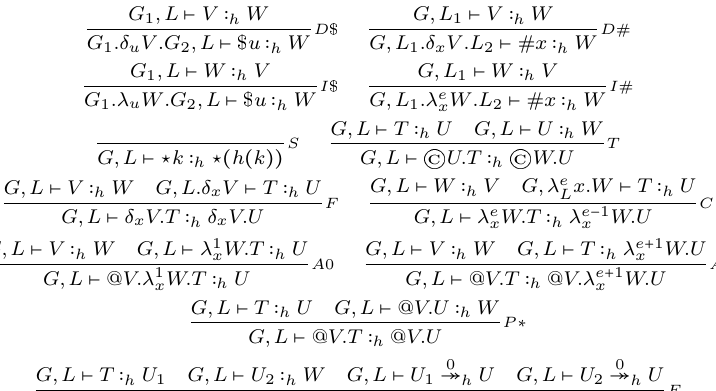
Fig. 7. The conjectured type assignment.